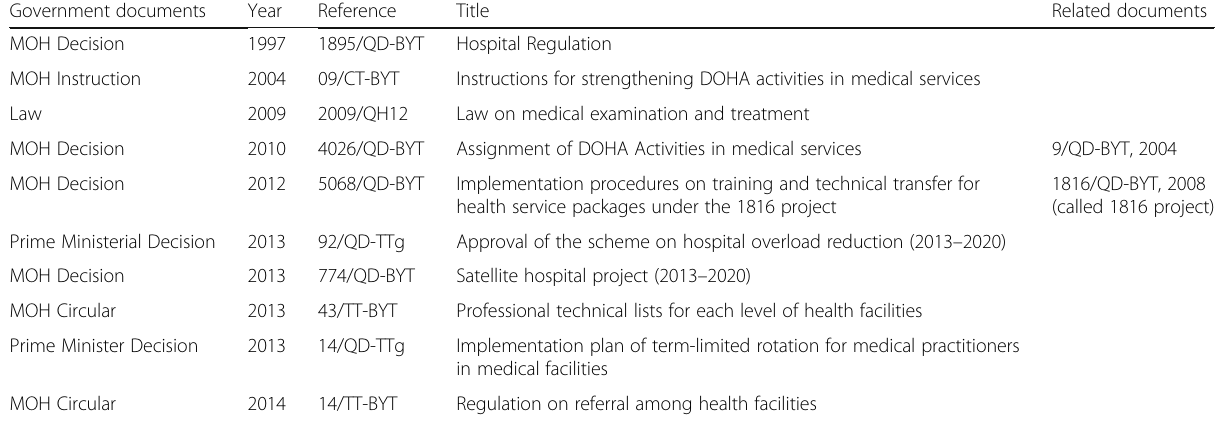
Table 2 Laws and regulations related to the Direction of Healthcare Activities